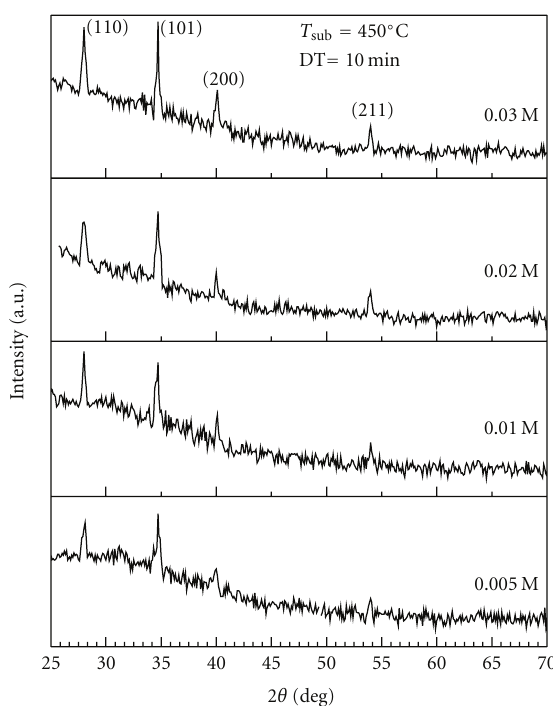
Figure 2: X-ray di ff raction patterns for IrO 2 films as a function of solution molarity at T sub = 350 ◦ C and deposition time = 10 minutes.